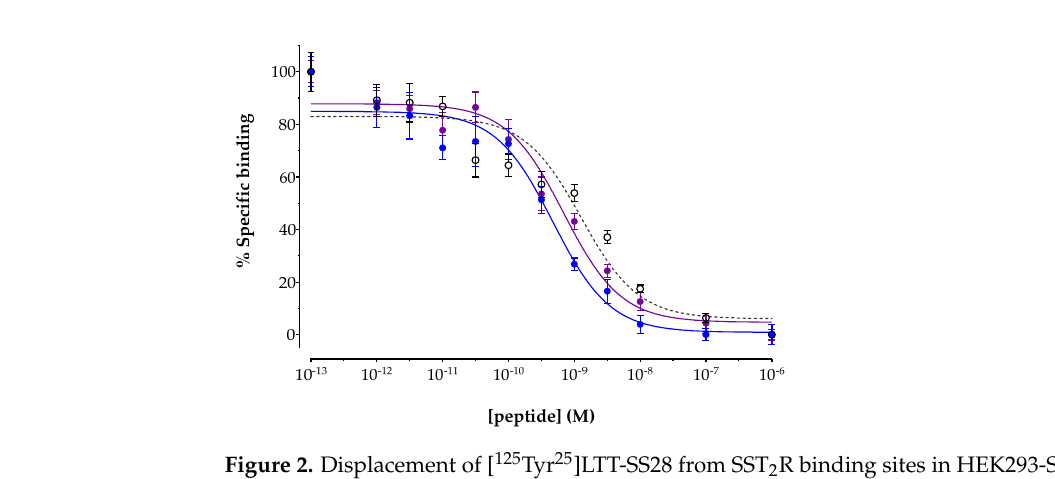
Figure 2. Displacement of [ 125 Tyr 25 ]LTT-SS28 from SST 2 R binding sites in HEK293-SST 2 R cell membranes by increasing concentrations of AAZTA 5 -LM4 (IC 50 = 1.69 ± 0.47 nM, n = 4); • [ nat In]In-AAZTA 5 -LM4 (IC 50 = 0.45 ± 0.05 nM, n = 3) and • [ nat Lu]Lu-AAZTA 5 -LM4 (IC 50 = 0.55 ± 0.38 nM, n = 3); results represent mean IC 50 values ± sd, n : number of separate experiments in triplicate.